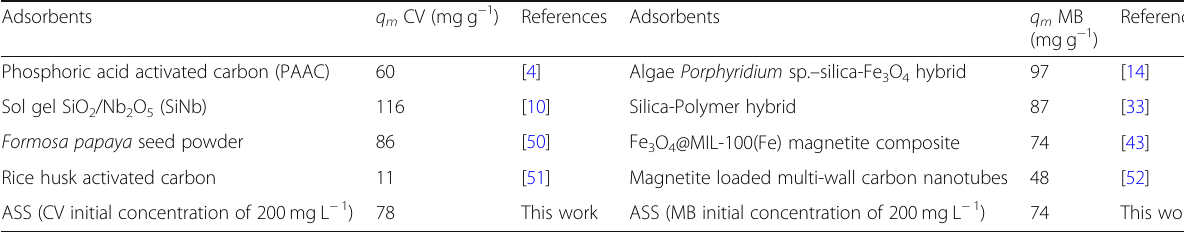
Table 3 Comparison of several adsorbents for CV and MB dyes